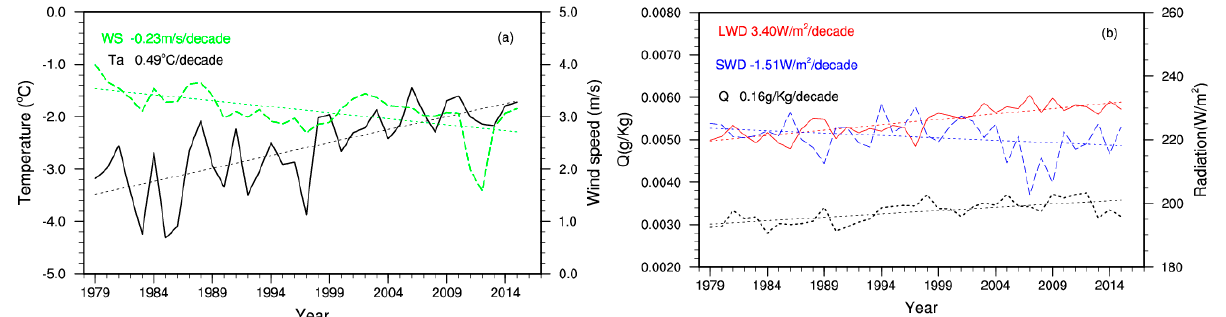
Figure 6. The ITPCAS annual mean meteorological variables and their trends: air temperature Ta and wind speed WS ( a ) and downward shortwave radiation SWD, downward longwave radiation LWD and specific humidity Q ( b ).